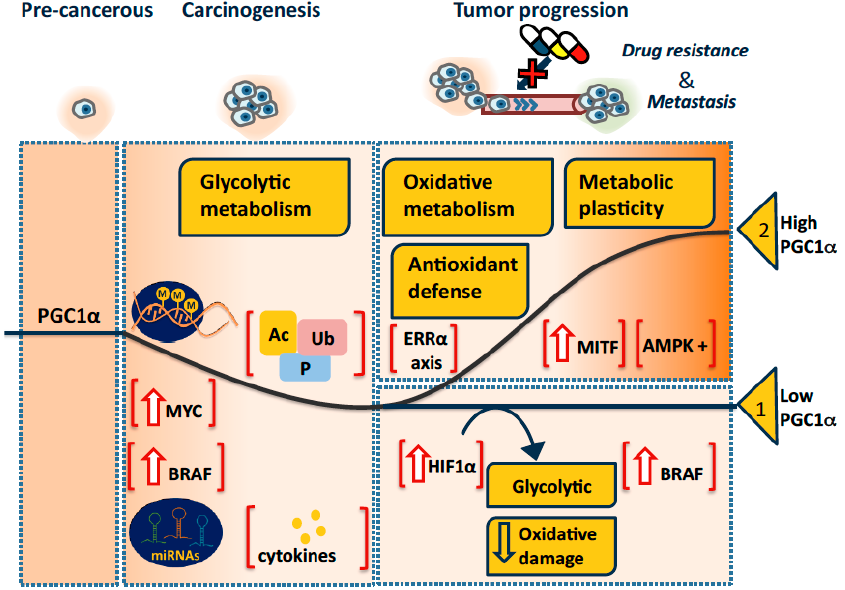
Figure 2. Schematic overview of PGC1 α levels in cancer during carcinogenesis, metastasis and acquisition of chemoresistance . This model proposes that carcinogenesis may in some tissues entail loss of a tumor-suppressive function of PGC1 α , and in many tissues also a switch to a glycolytic cell metabolism. PGC1 α downregulation may be due to promoter methylation or ubiquitinylation of the PGC1 α protein; both mechanisms are seen also in non-cancer cells [25,70]. Transcriptional repression